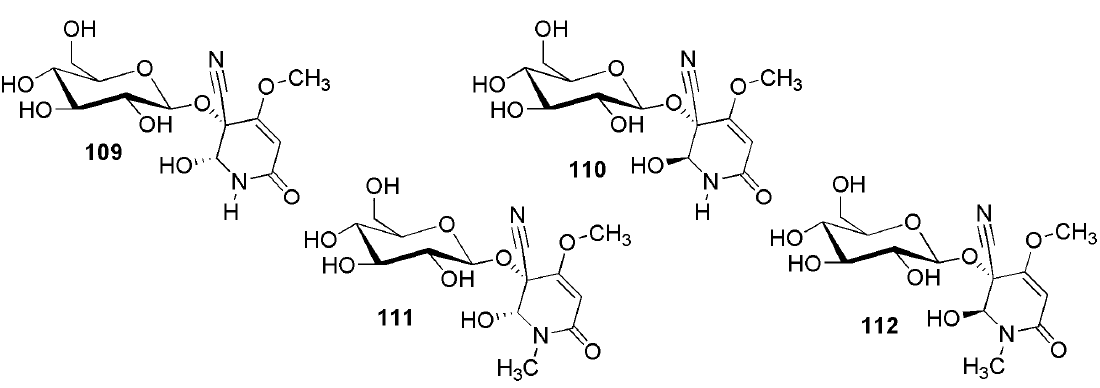
Figure 18. Cyanogenic glycosides group D, dihydropyridone derivatives: (5 R ,6 R )-epinoracalyphin